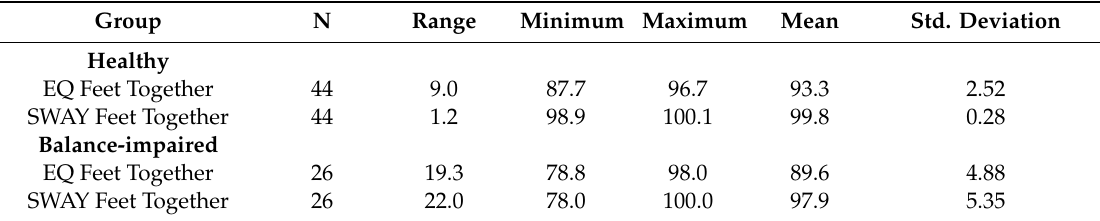
Table 4. Variability of results for the feet together stance, separated by healthy vs. balance-impaired